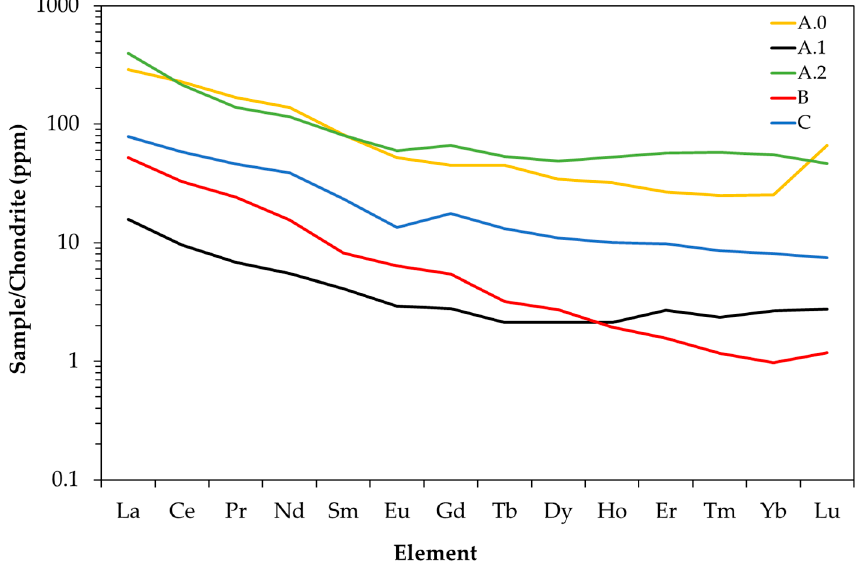
Figure 2. Chondrite-normalized REE plot for materials from iron ore mining.